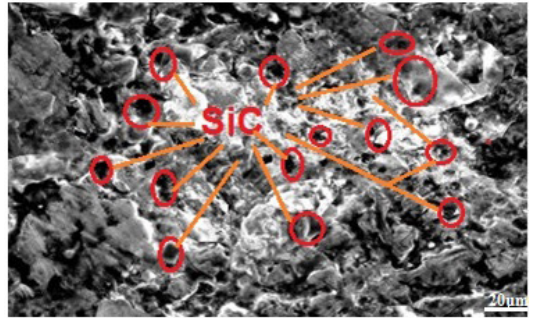
Figure 1. Microstructureof AA7075 with 15 wt % SiC.